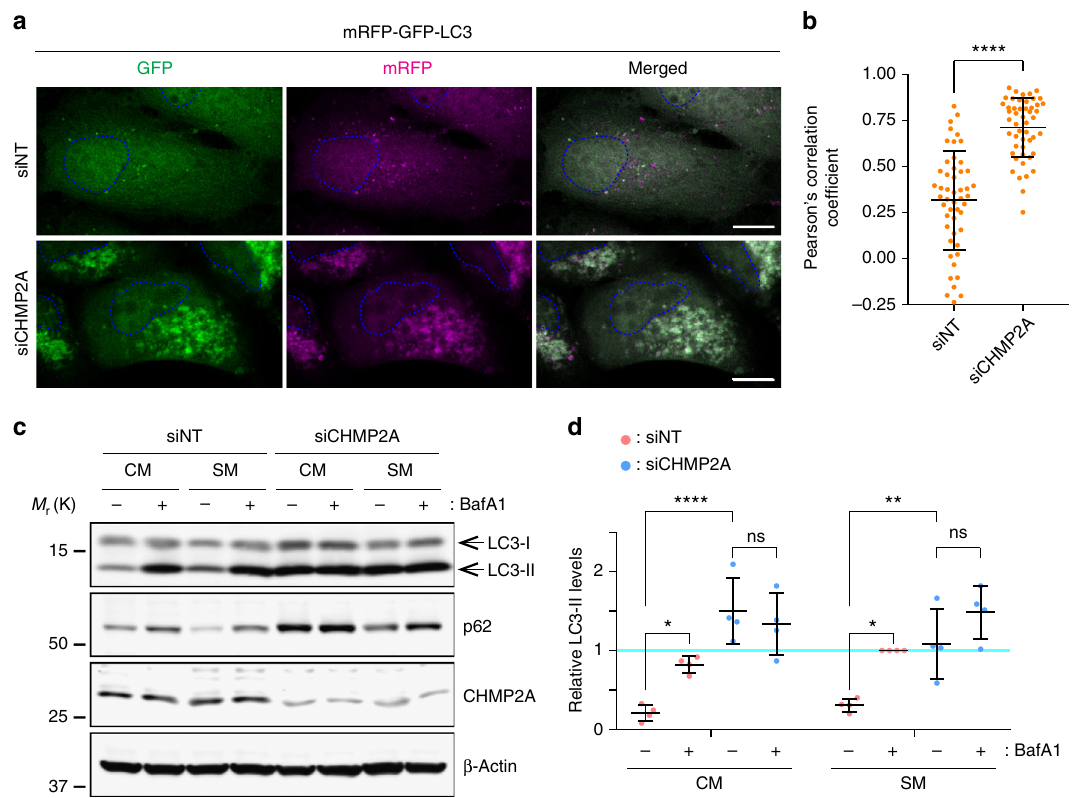
Fig. 4 CHMP2A depletion impairs autophagic fl ux. a , c U-2 OS cells were transfected with the indicated ON-TARGETplus SMART Pool siRNAs. a Eight hours after transfection, cells were transduced with lentiviruses encoding mRFP-GFP-LC3, cultured for 40 h, incubated in CM or SM for 3 h, and subjected to confocal microscopy. The images shown are representative from the starved groups shown in Supplementary Fig. 6d. The scale bars represent 10 μ m. b The acidi fi cation of autophagic structures in ( a ) was assessed by Pearson ’ s correlation coef fi cient. Fifty cells from each group were analyzed. Statistical signi fi cance was determined by Mann – Whitney nonparametric t -test. All values are mean ± SD. **** p ≤ 0.0001. c Forty-eight hours after transfection, cells were incubated in CM or SM in the presence or absence of 100 nM BafA1 for 3 h and subjected to immunoblotting using the indicated antibodies. Representative blots from four independent experiments are shown. d The LC3-II levels relative to respective β -actin in ( c ) were quanti fi ed and normalized to the value of starved, siNT-transfected cells. Statistical signi fi cance was determined by two-way ANOVA followed by Tukey ’ s multiple comparison test. All values are mean ± SD. ns not signi fi cant; * p ≤ 0.05; ** p ≤ 0.01; **** p ≤